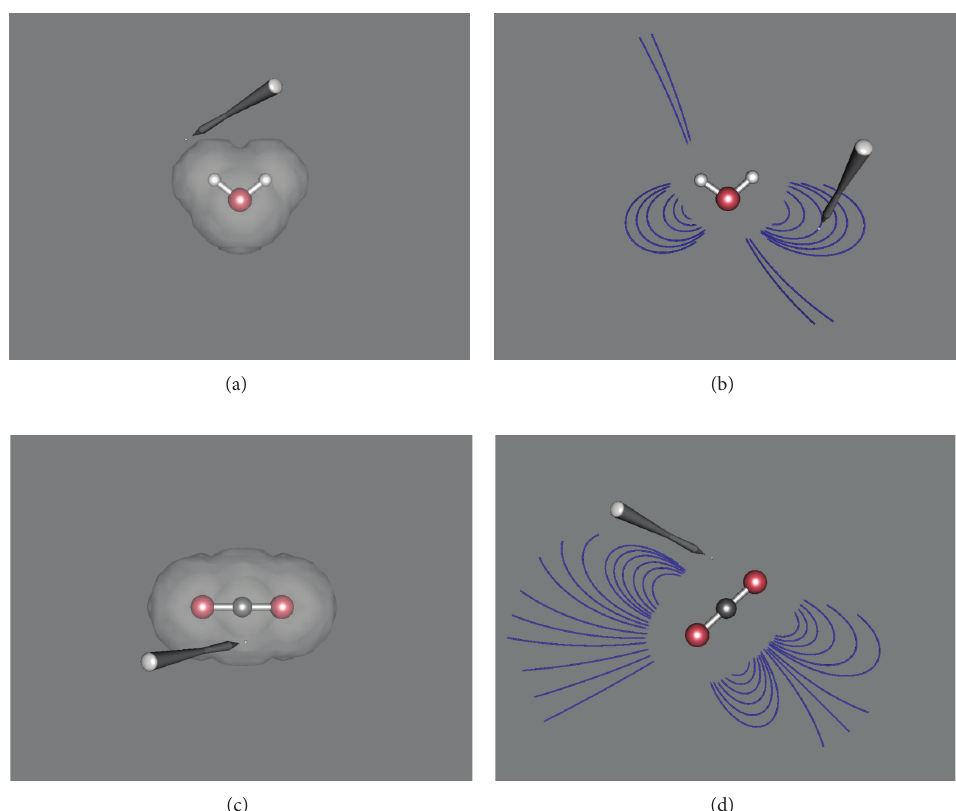
Figure 1: A panel of four screenshots from the virtual system displaying an H 2 O molecule with a van der Waals surface (a), an H 2 O molecule with visual field lines (b), and a corresponding CO 2 molecule displayed in the same modes (c) and (d), all in a “ball-and-stick” representation. While interacting with the system, the viewer receives a 3D stereoscopic view of the molecules and can also rotate them. The stylus that represents the handle of the haptic device is also shown with the probe (small white